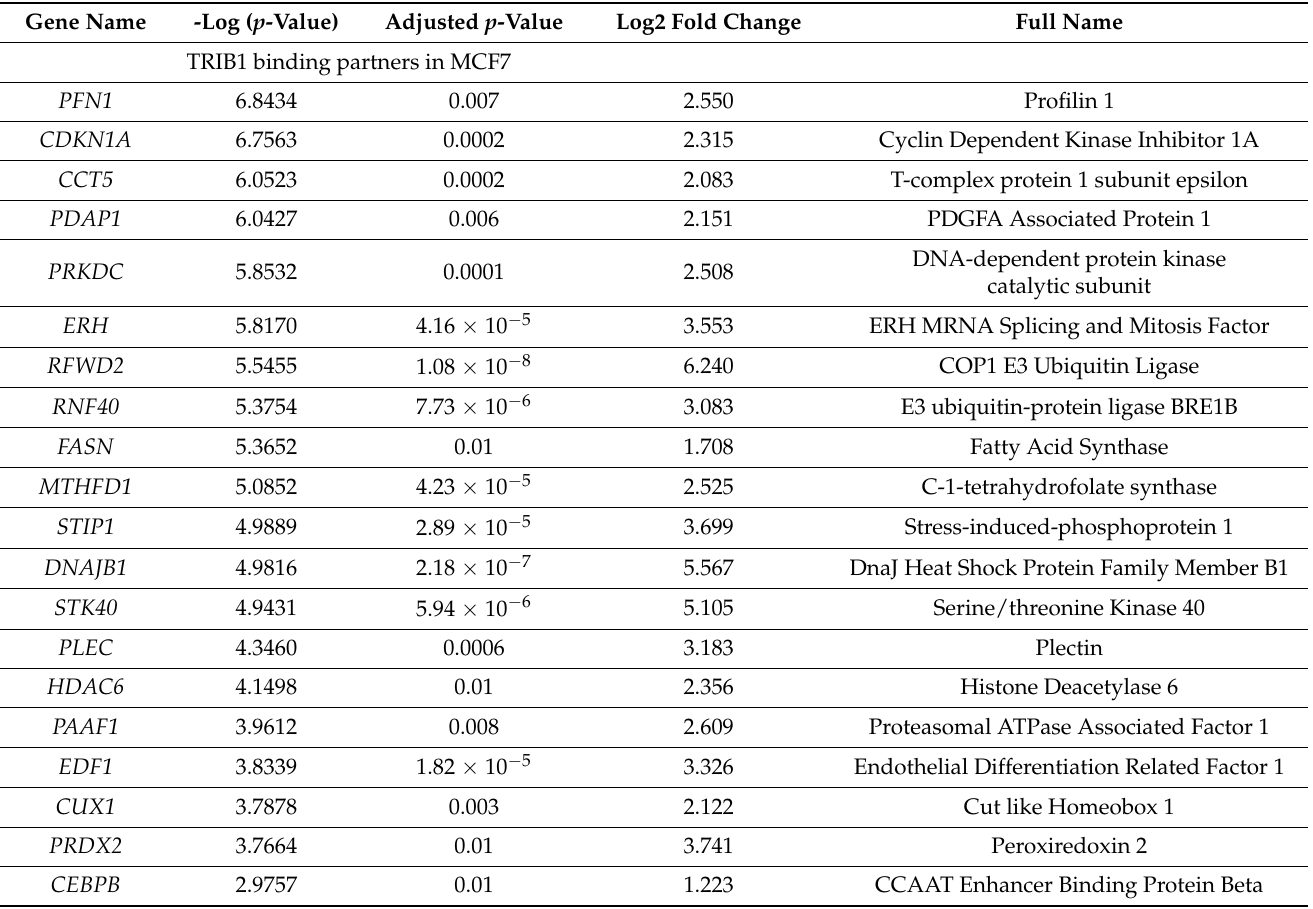
Figure 3. TRIB1 and TRIB3 interactors in MCF7 cells. ( A ) Schematic representation of inducible constructs and workflow of the AP–MS experiments followed in MCF7 cells. ( B ) Western blot using t-GFP antibody sowing inducible expression of TRIB1-tGFP and TRIB3-tGFP upon doxycycline treatment and Tubulin expression as loading control. ( C ) Confocal images taken at 40× magnification showing tGFP, TRIB1-tGFP and TRIB3-tGFP localization upon doxycycline induction. ( D ) Volcano plots of TRIB1 and TRIB3 interactors compared with tGFP control in MCF7 cells and a volcano plot showing the comparison between TRIB1 and TRIB3 interactome in these cells. ( E ) Venn diagram of similar and different interactors between TRIB1 and TRIB3 in MCF7 cells detected in the AP–MSMS experiments. ( F ) Gal4 reporter assay of Gal4-DBD and Gal4-TRIB3 in MCF7 cells. Data is normalized using Renilla luciferase. Data is indicated as mean ± SEM. p -values were calculated using two-tailed Student’s t -test (* p < 0.05). Table 5. Top 20 TRIB1 and TRIB3 binding partners in MCF7 cells based on p